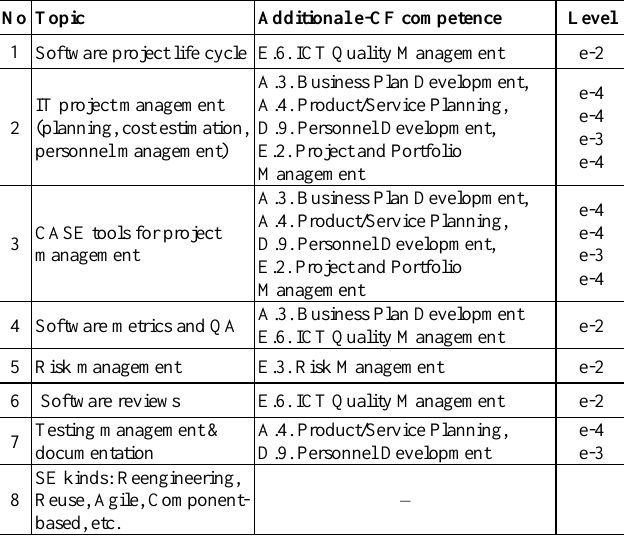
TABLE II T OPICS AND E -CF C OMPETENCES IN THE M ASTER S TUDY P